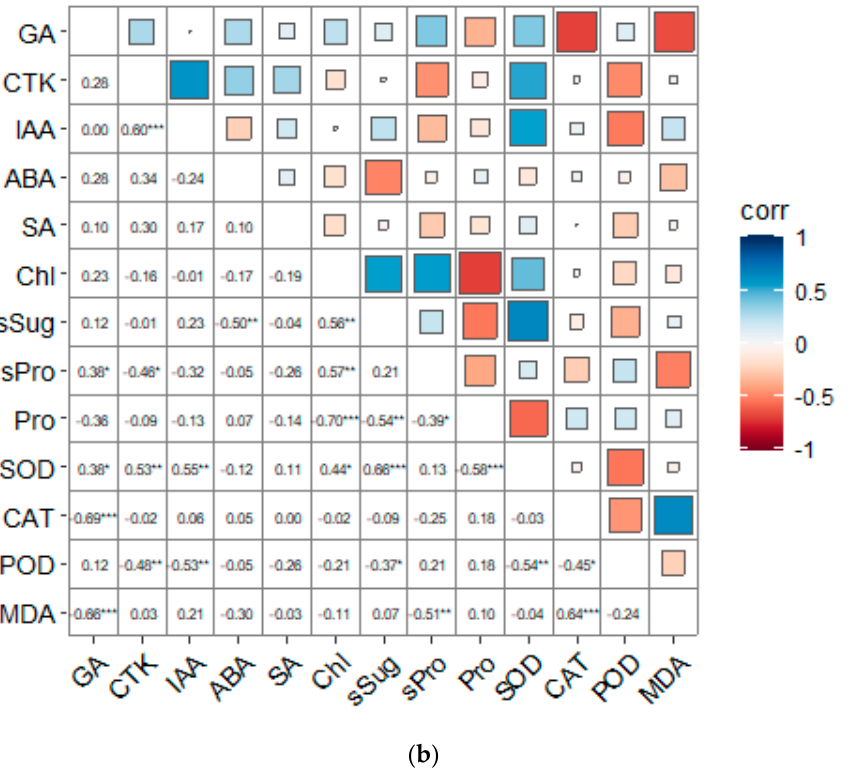
Figure 7. Correlation of physiological indexes of Populus cathayana × canadansis ‘Xin Lin 1’ under 100 μ M ( a ) and 800 μ M ( b ). The size of the solid square indicates the correlation degree, with blue representing positive correlation and red representing negative correlation. Images use *, ** and *** to indicate the significance between indicators. * means p value < 0.1; ** means p value < 0.05; *** means p value < 0.01.